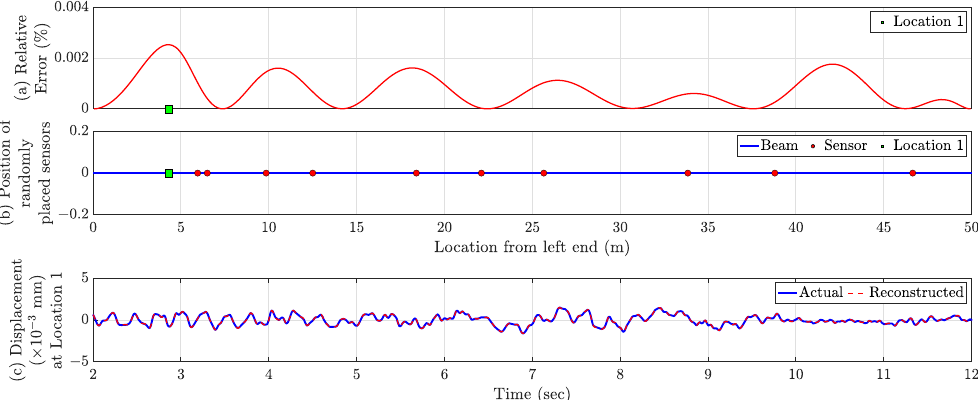
Figure 5. ( a ) Relative Errors ( (cid:101) i ) in % for the virtual dense sensing points. The ‘green square’ marker represents the location of maximum relative error. ( b ) Location of actual sensors (shown as ‘red circles’). ( c ) Comparison of actual and reconstructed time history response at Location